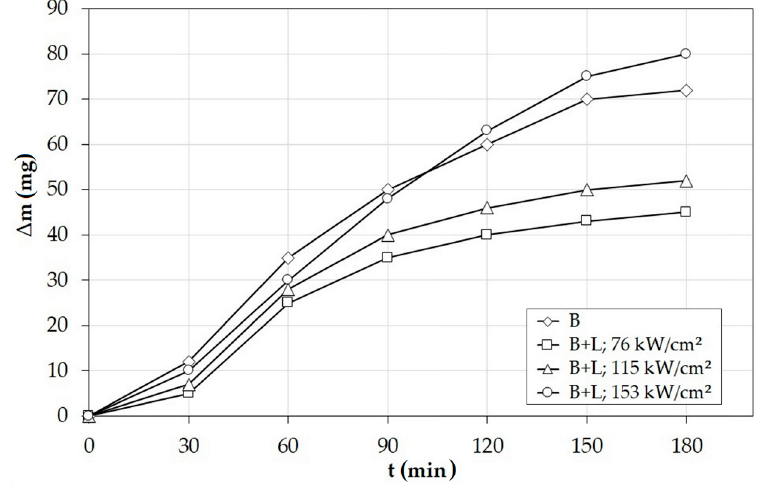
Figure 8. Wear resistance of a diffusion boronized layer and FeB-Fe 2 B-Fe 3 (B,C) layers produced by laser processing using 76 kW/cm 2 , 115 kW/cm 2 , and 153 kW/cm 2 .